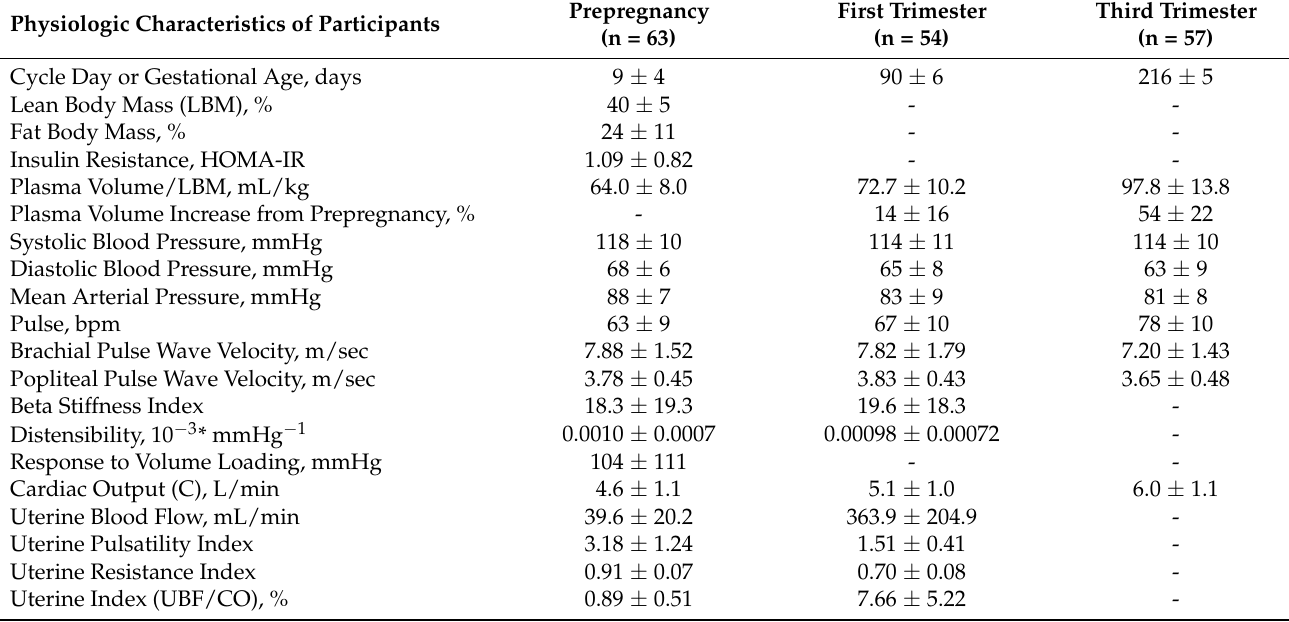
Table 2. Physiologic assessments of the study population, means at each study visit. Data are presented as mean ± standard deviation unless otherwise indicated. - indicates that the assessment was not completed during that study